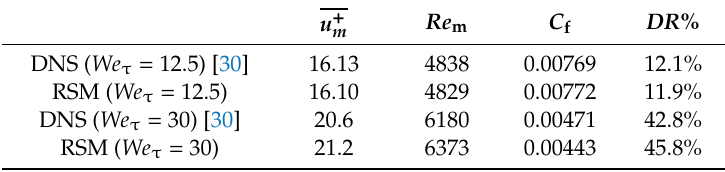
Table 2. Comparison of bulk mean variables with literature [30].